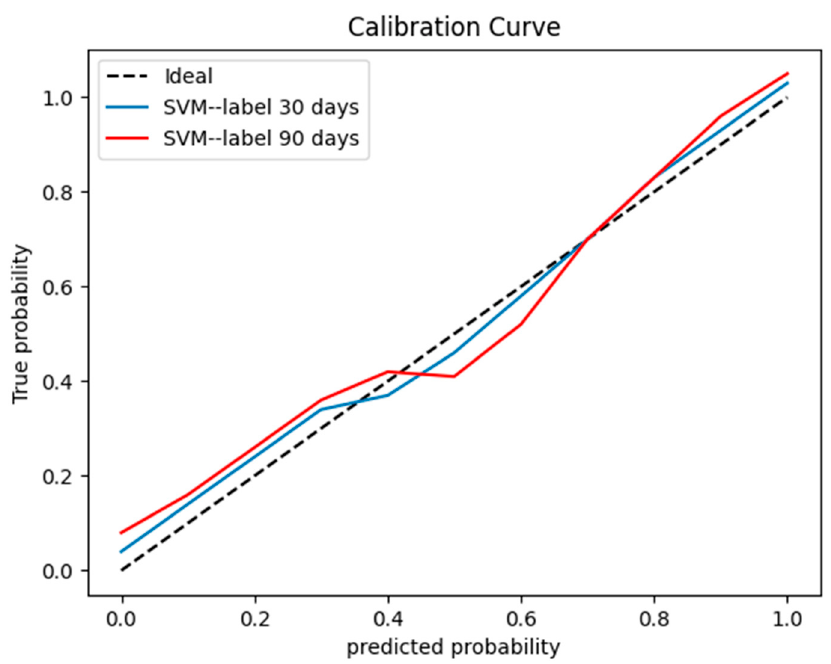
Figure 4. A calibration curve for the testing set.